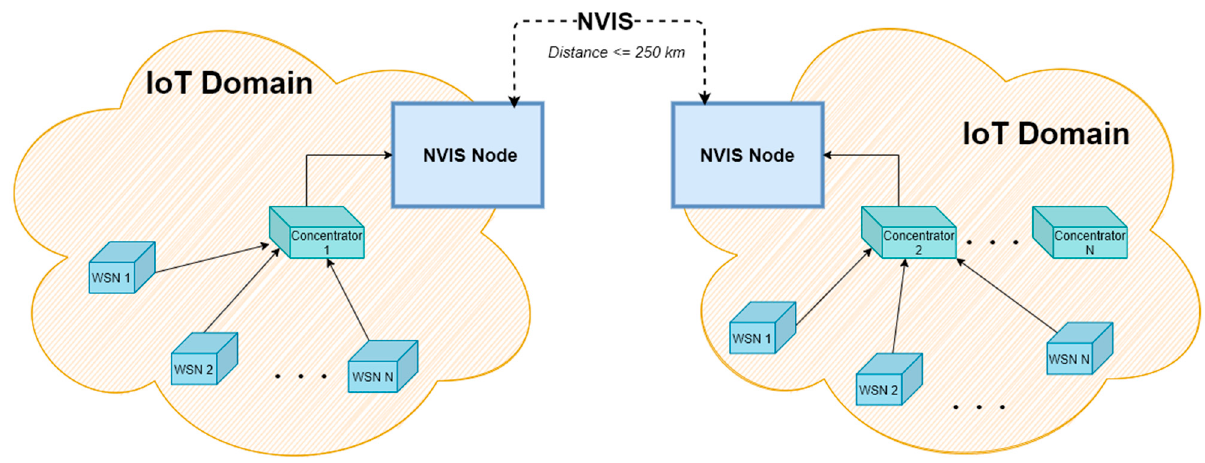
Figure 3. System model deployment.